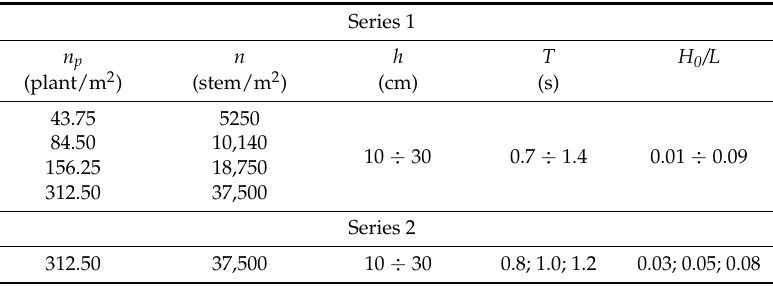
Table 1. Summary of the tests in wave